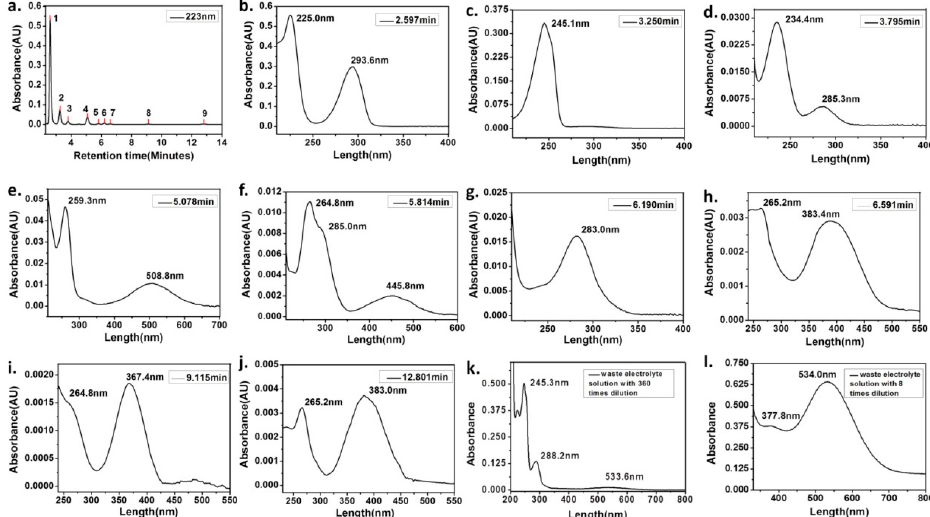
Figure 1. ( a ) HPLC chromatograms of an n-octanol extract of the waste electrolyte solution. Solution obtained after 10 times electro-polymerization. UV–vis spectrum of the composition of sample A; ( b ) peak 1, retention time (RT) = 2.957 min; ( c ) peak 2, RT = 3.250 min; ( d ) peak 3, RT = 3.795 min; ( e ) peak 4, RT = 5.078 min; ( f ) peak 5, RT = 5.81 min; ( g ) peak 6, RT = 6.190 min; ( h ) peak 7, RT = 6.591 min; ( i ) peak 8, RT = 9.115 min; ( j ) peak 8, RT = 12.901 min; UV–vis spectrum of the waste electrolyte solution solution with different dilution factors ( k ) 360 and ( l ) 8. Conditions for electro-polymerization were: (1) the initial concentration of aniline was 0.25 M and 0.75 M H 2 SO 4 ; (2) the voltage difference between working electrode and counter electrode was 1.58 V, the working electrode potential is about 0.90 V vs. saturated calomel electrode (SCE); (3) the reaction temperature was 293 K; (4) the reaction time was 20 min; (5) the working electrode and counter electrode were stainless steel (SS) (electrode area is 8.0 × 10.0 cm) and the distance between these was about 1.0 cm. Conditions for HPLC-DAD were: (1) injection volume was 10 µ L; (2) composition of the mobile phase was high purity water / ACN = 45 / 55; (3) flow rate of mobile phase was 0.6 mL / min; (4) the analytical column (Atlantis dc18 Column, 100 Å, 5 µ m, 3 × 100 mm) was thermo-stated at 298 K. Waters model 1525 HPLC with 2998 photodiode array detector and a HP-8453E UV–vis spectrophotometer